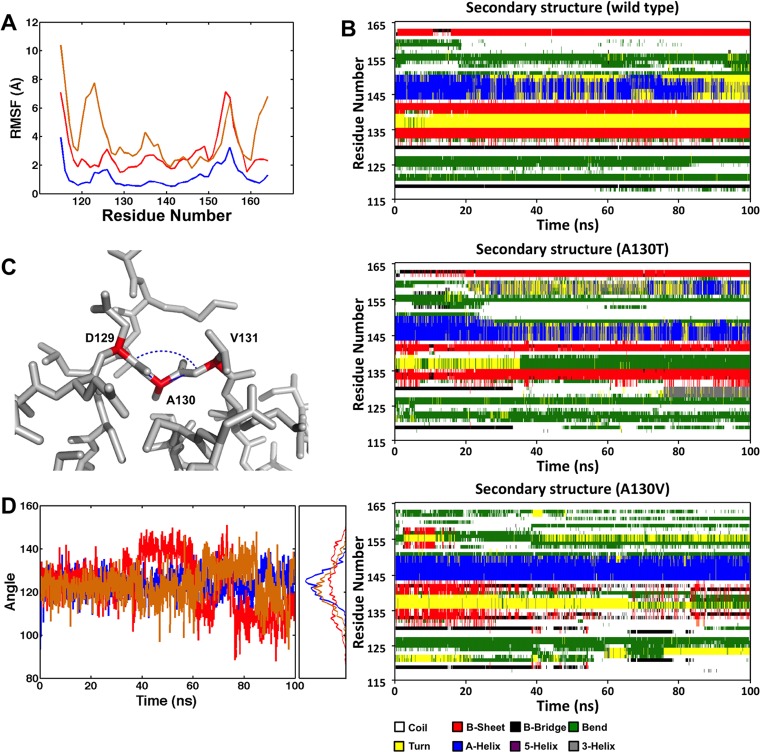
Structural analysis of the MD simulation results.(A) Backbone RMSFs for WT (blue), A130T (red), and A130V (orange) during the MD simulations. (B) Time evolution of the secondary structural elements, based on DSSP classification, of the wild type and mutant proteins. (C) The angle formed by the Cα atoms of D129, A130, and V131. (D) The angle fluctuations for WT (blue), A130T (red), and A130V (orange) during the MD simulations with the corresponding histogram to the side.